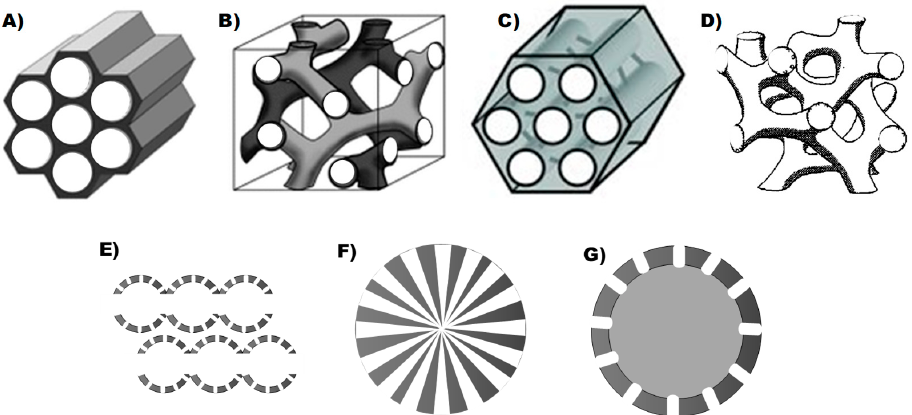
Figure 1. The most common porous silica structures for drug delivery: ( A ) hexagonal MCM-41; ( B ) cubic MCM-48 (adapted with permission from [33], copyright Wiley 2006); ( C ) hexagonal with microporous connections SBA-15 (adapted with permission from [34], copyright Wiley 2012); ( D ) disorder LMU-1 (adapted with permission from [35], copyright American Chemical Society 2008); ( E ) mesocellular foam IBN-3 [36,37]; ( F ) dendritic pores [38]; ( G ) mesoporous hollow particles [39].